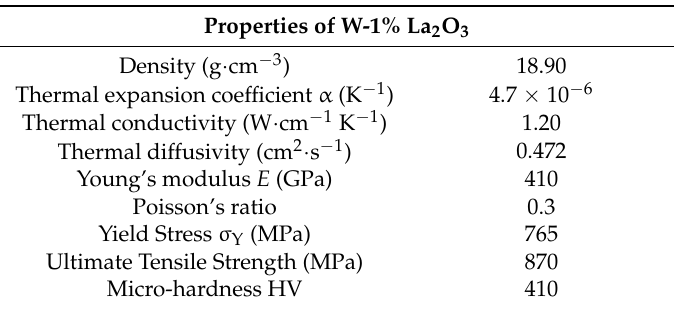
Table 1. Thermo-mechanical properties of W-1% La 2 O 3